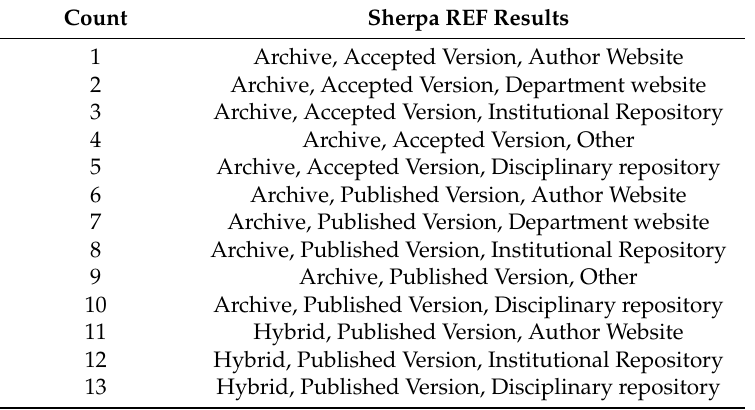
Table 3. The Sherpa REF results: open access dissemination options for the Journal of Applied Physics (AIP